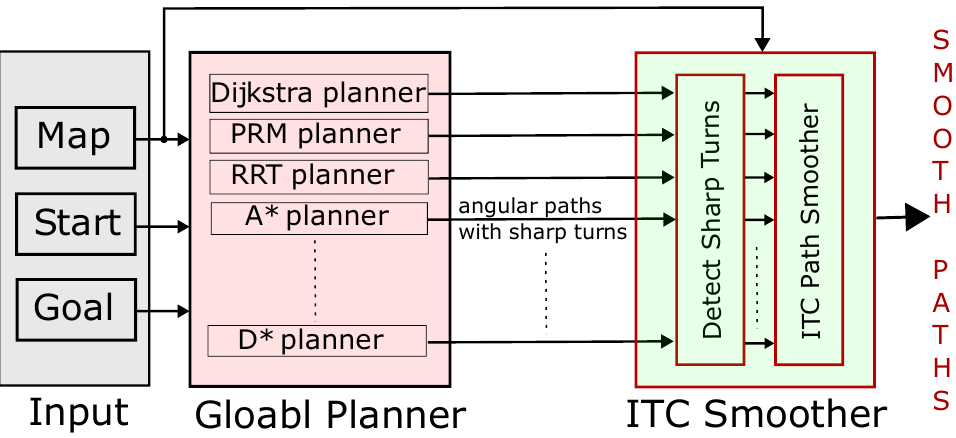
Figure 27. ITC path smoothing